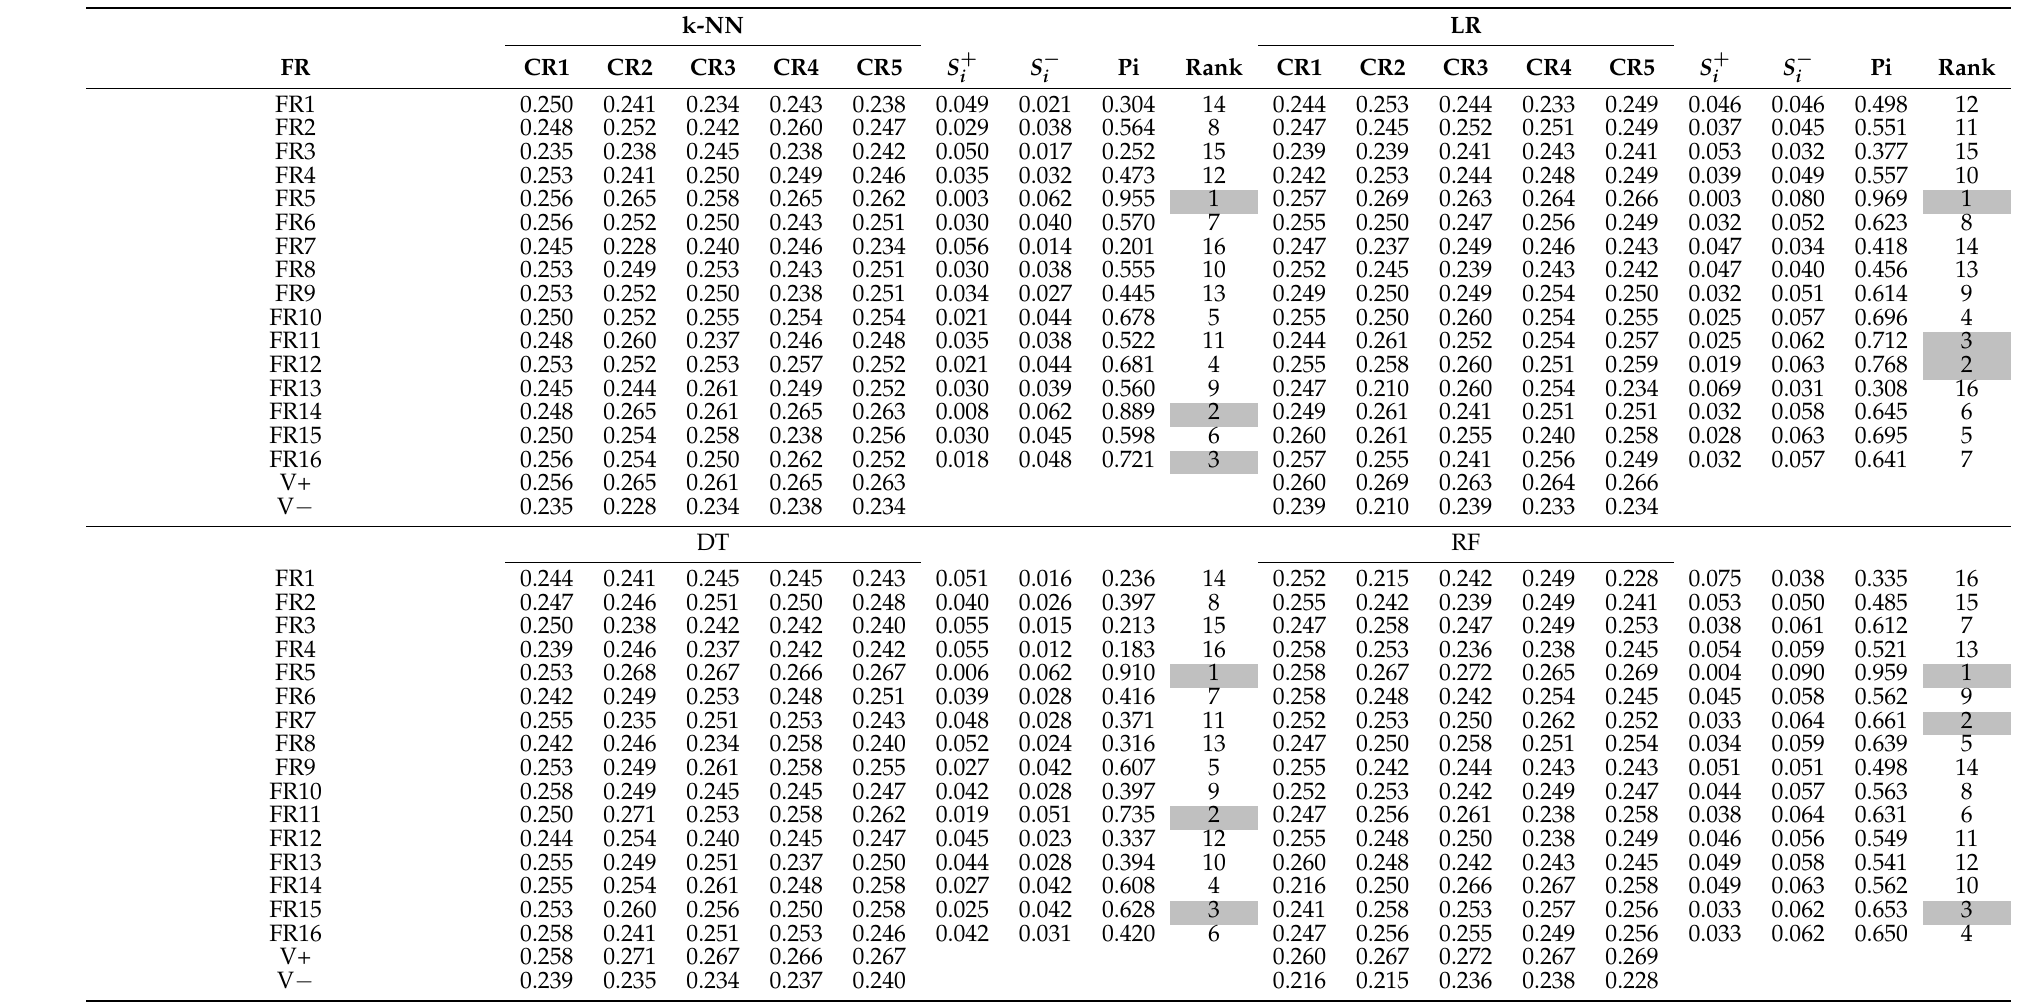
Table 6. Results of TOPSIS for Colon Cancer Dataset with Ranking of Feature Reduction Sequence using Dataset